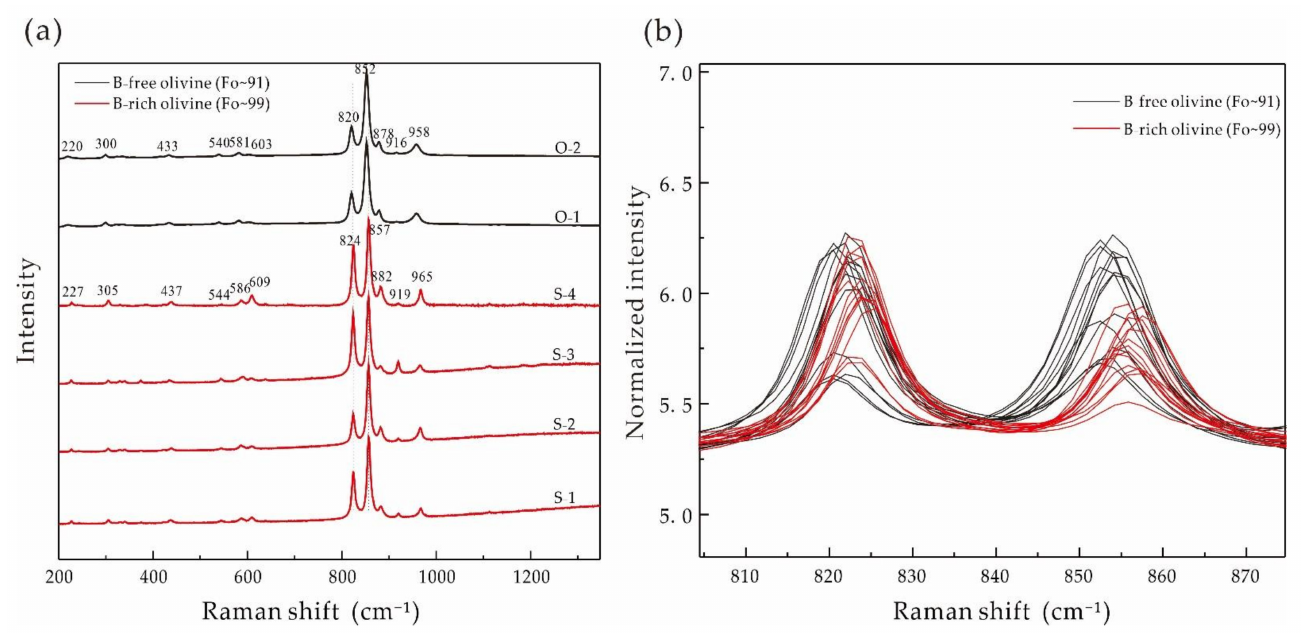
Figure 5. Raman spectrum of B-rich forsterite compared with mantle olivine. ( a ) The Raman spectrum of samples. ( b ) The magnification of ( a